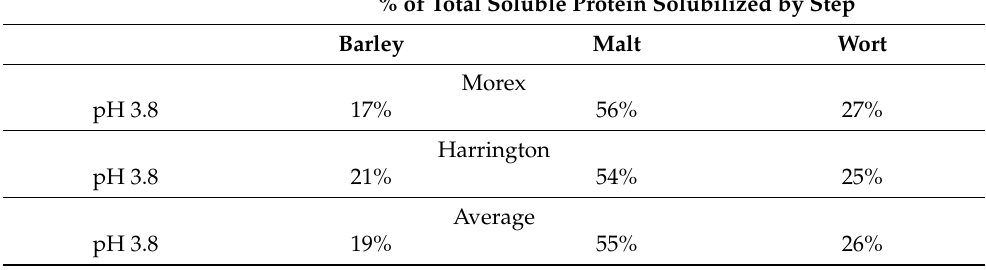
Table 3. The soluble protein of commonly used Morex and Harrington barleys, malts, and worts, adapted from